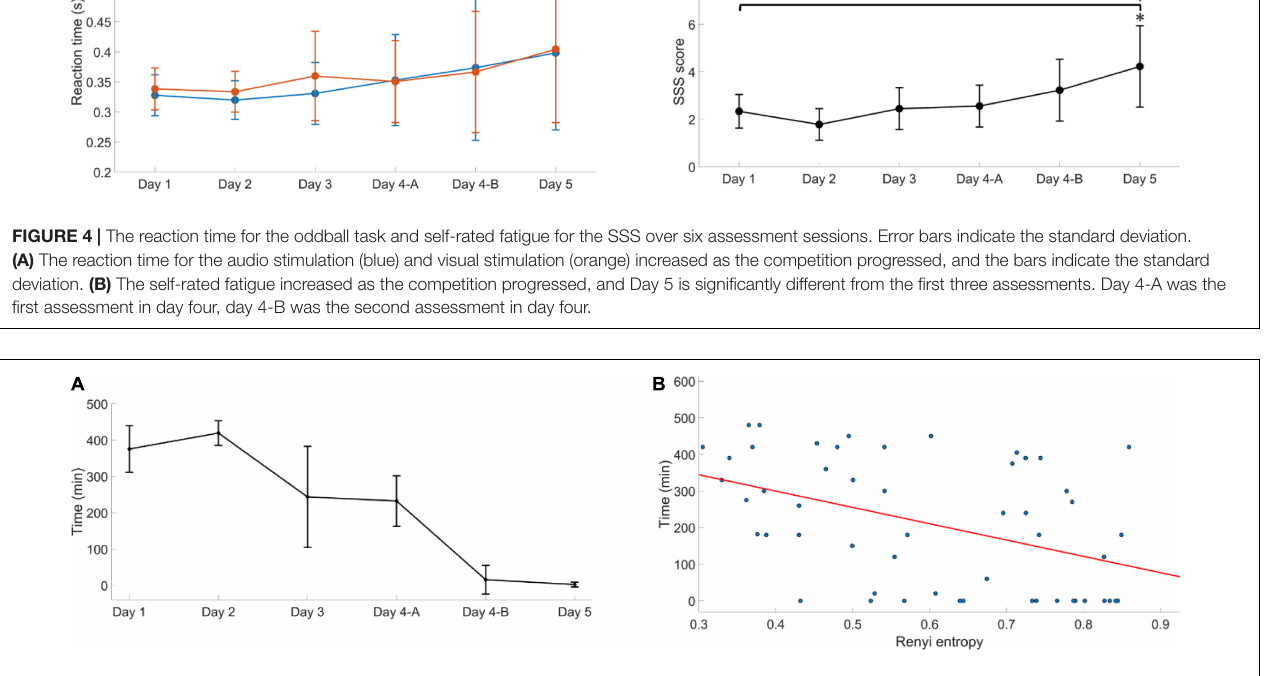
FIGURE 5 | Sleep time changes during the competition. (A) The total sleep time before each assessment. Error bars represent standard deviation. Day 4-A was the first assessment in day four, day 4-B was the second assessment in day four. (B) The EEG Rényi entropy and sleep time correlation